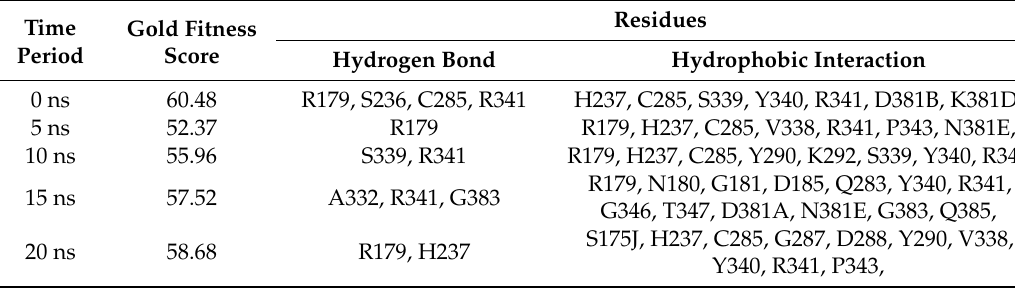
Table 4. Binding e ffi cacy of ZINC04534268 against caspase 8 at di ff erent time intervals and the active site residues involved in the